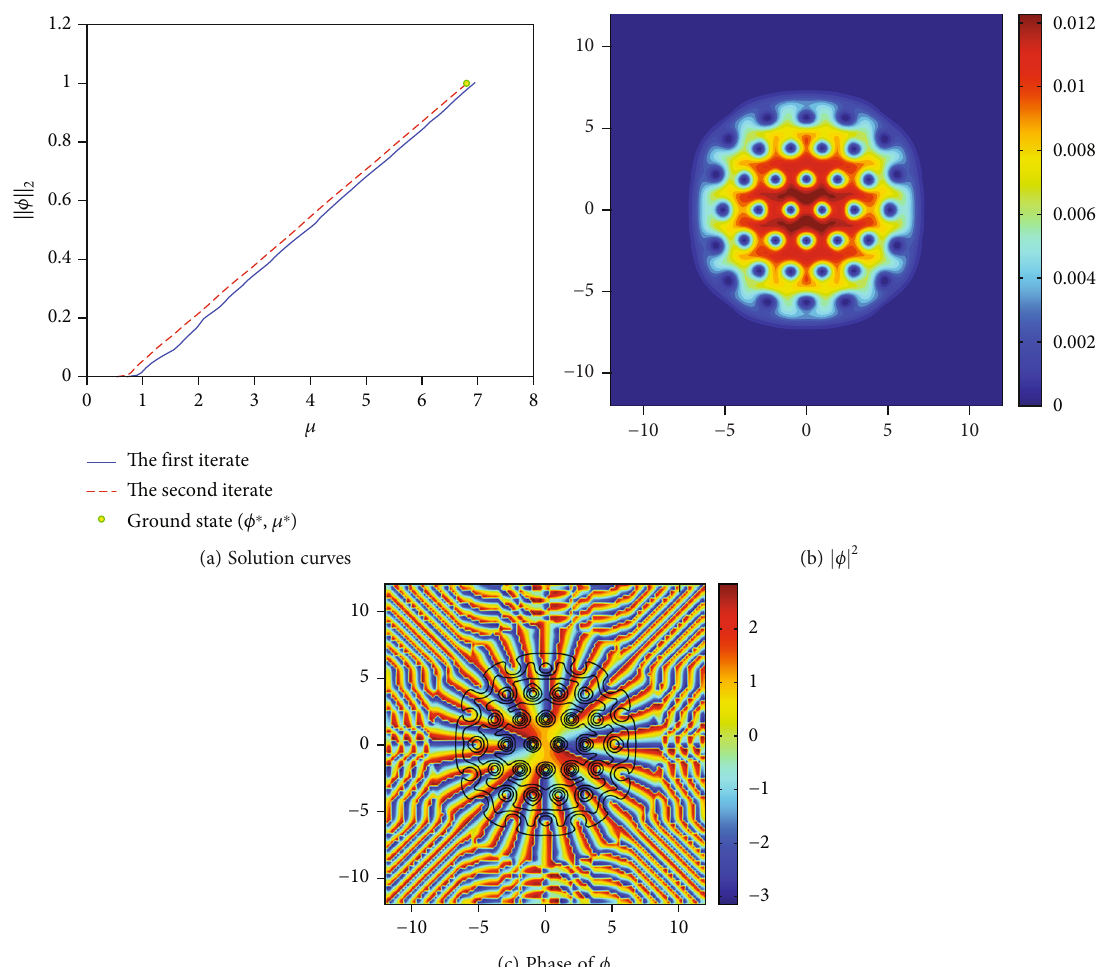
Figure 1: The solution curves, the contour plot of j ϕ j 2 , and the phase of ϕ for the ground state solution of (15), where V x 2 + 0 : 997 y 2 Þ /2 , ε = 1/